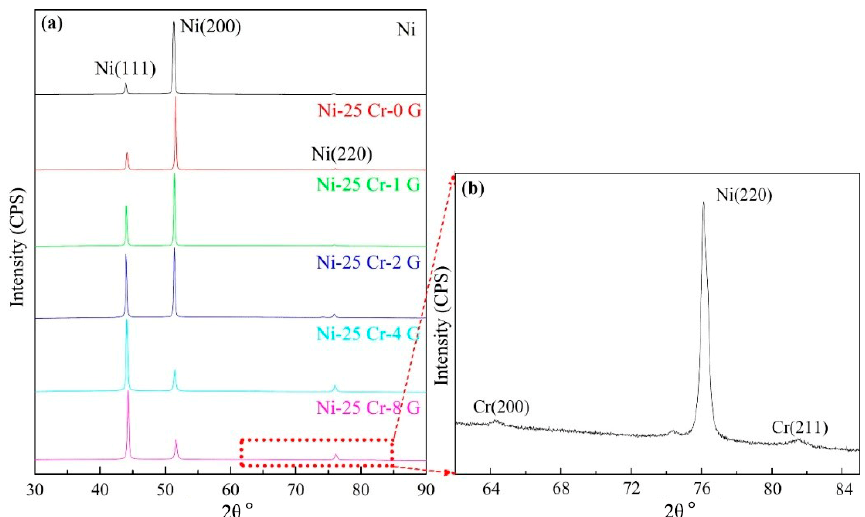
Figure 6. ( a ) X-ray diffraction (XRD) results of the Ni–Cr–graphene coatings with